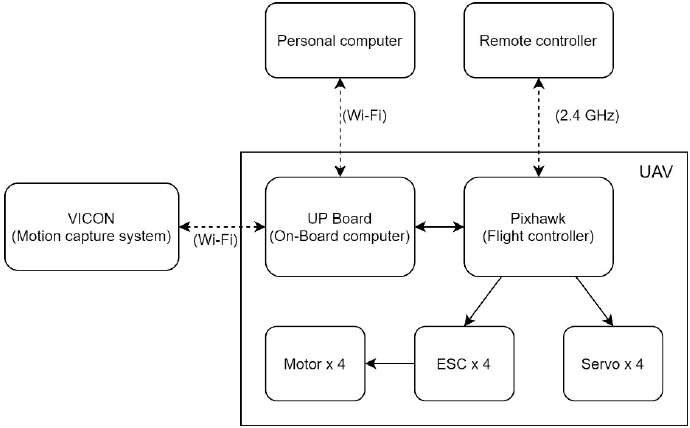
Figure 11. Avionics network structure.